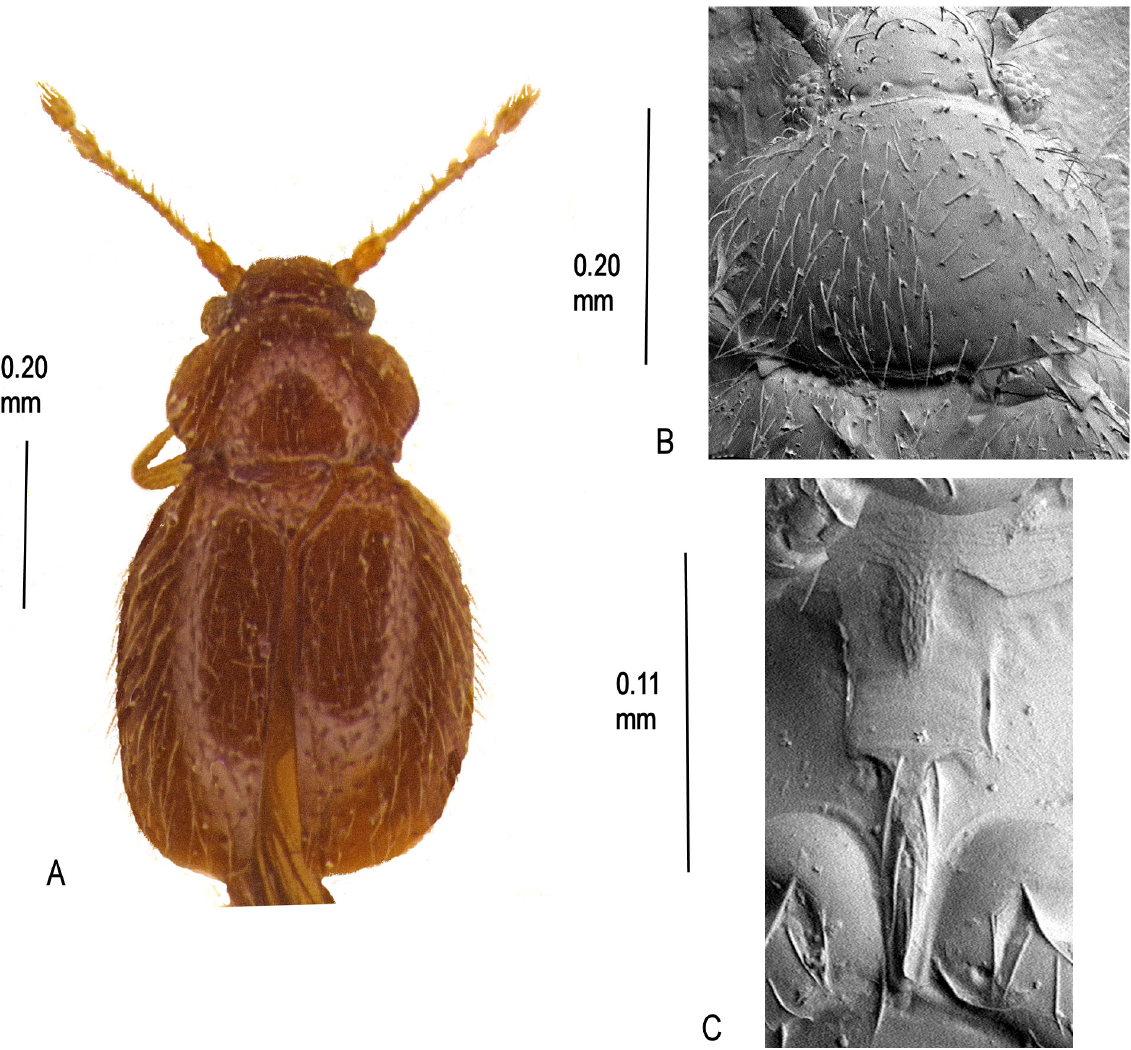
Fig. 76 . Cissidium obscurum sp. nov. A . Habitus. B . Pronotum, × 560. C . Mesoventrite showing median process of collar, mid-keel and keel,